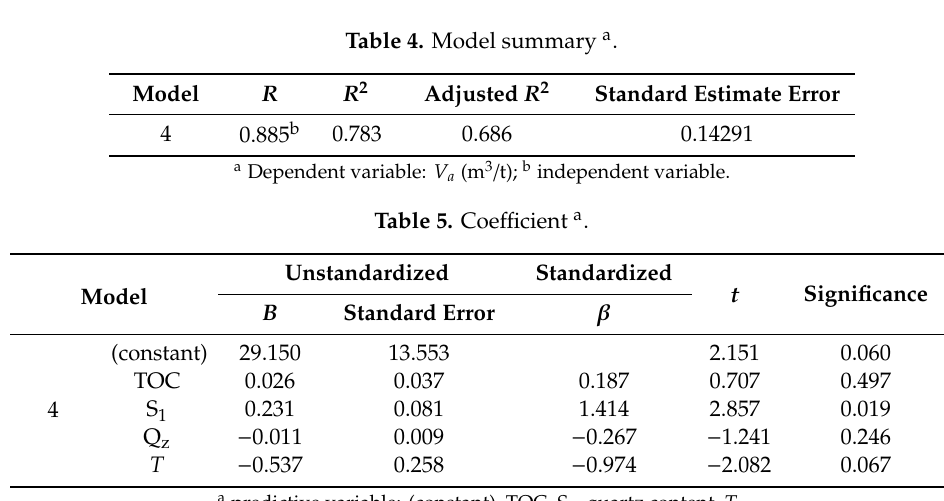
Table 4. Model summary a .